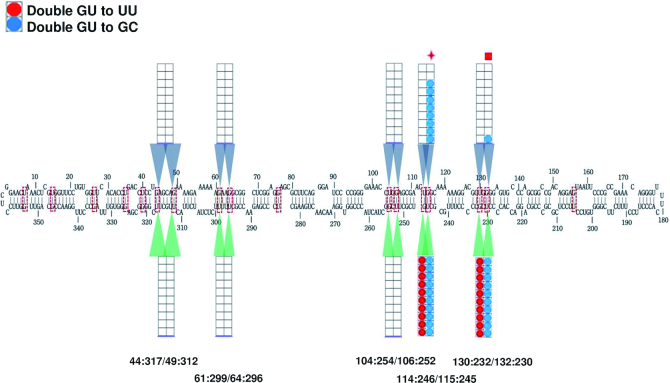
Replication and trafficking rates for PSTVd G/U double mutants. For each stem region containing two G/U pairs, G/U to U/U and G/U to G/C single mutants were separately combined to generate double mutants. The nucleotide coordinates for the coupled G/U pairs are given below the diagram of the canonical PSTVd secondary structure. Ten N. benthamiana plants were inoculated with each mutant and RNA from inoculated (local) and systemically infected leaves was evaluated for the presence of PSTVd by RNA blot analysis. For each mutation type, 10 boxes within a grid represent 10 inoculated plants. Lower grids show data for local inoculated leaves, where positive signals indicate replication. Upper grids show data for systemically infected leaves, where positive signals indicate potential systemic trafficking. Colored circles represent infected plants: double G/U to U/U (red); double G/U to G/C (blue). Symbols above the diagram represent results of progeny sequencing from systemically infected leaves. Red cross: retained one introduced mutation, one reverted to G/U. Red square: lost both introduced mutations (reverted to G/U) and acquired a new mutation. For single mutant data, see Figure 4.